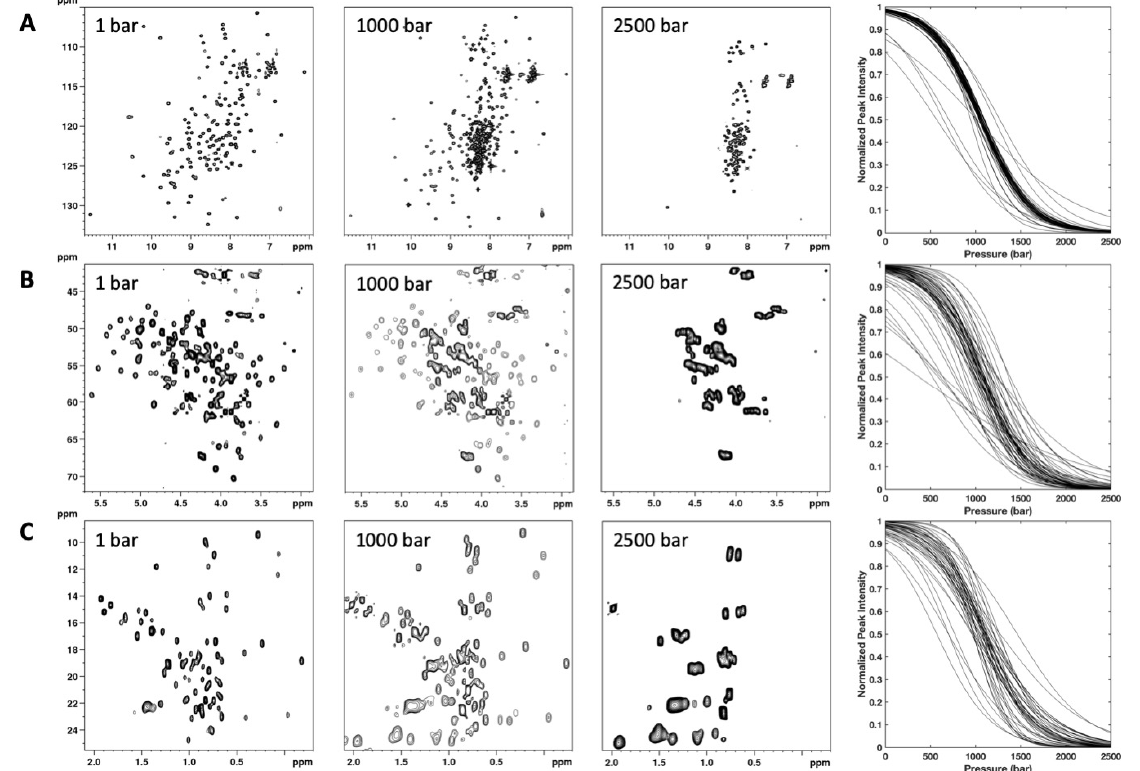
Figure 3. NMR detected high-pressure unfolding of ∆ +PHS SNase. From left to right, examples of 2D [ 1 H, 15 N] ( A ) and [ 1 H, 13 C] ( B , C ) HSQC spectra recorded at 1, 1000, and 2500 bar are displayed. In ( B , C ), only a zoom on the C α H α or on the CH 3 cross peak region, respectively, is displayed. The rightmost panels report overlays of the normalized residue-specific denaturation curves obtained from the fits of the pressure-dependent sigmoidal decrease of ( A ) NH amide, ( B ) C α H α , and C ) CH 3 cross peak intensities in the corresponding HSQC spectra with Equation [1]. Representative examples of experimental fits are given in Supplementary Materials (Figure S4).